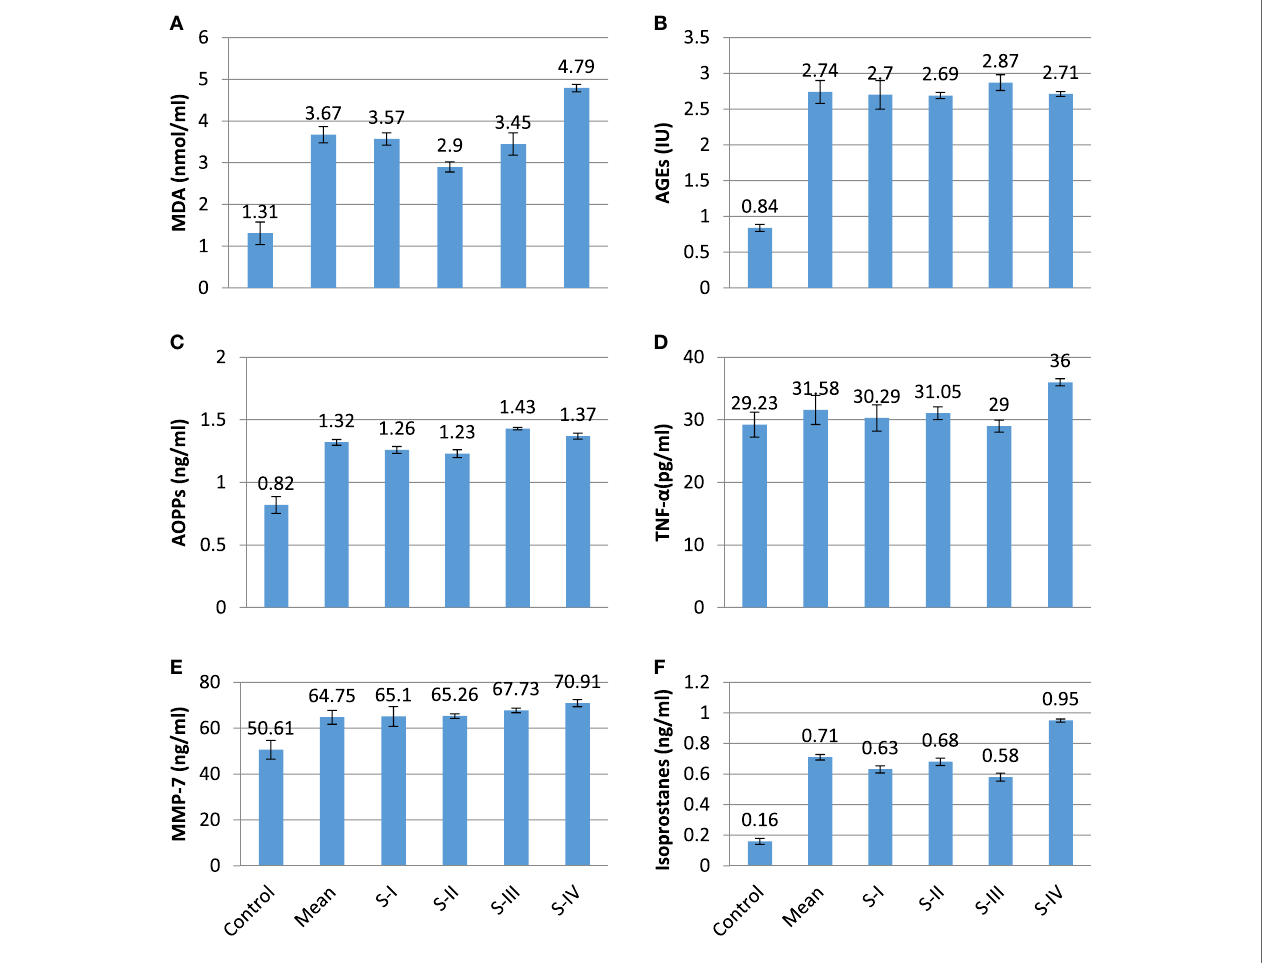
FigUre 2 | Profile of different prognostic variables in CA colorectal vs controls. (a) MDA (nmol/ml); (B) AGEs (IU); (c) advanced oxidation protein products (AOPPs) (ng/ml); (D) TNF- α (pg/ml); (e) matrix metalloproteinase-7 (MMP-7) (ng/ml); and (F) isoprostanes